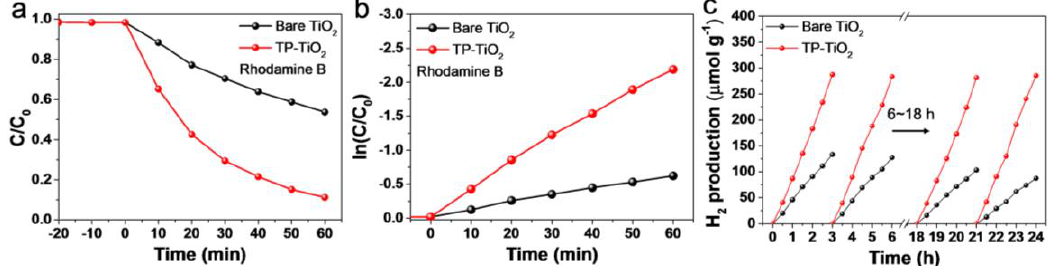
Figure 3. ( a ) Concentration changes in rhodamine B aqueous solution by photodegradation; ( b ) Natural logarithmic plots for the study of the kinetics of rhodamine B photodegradation profiles; ( c ) Photocatalytic hydrogen production and cycling performance during 24 h of continuous reaction in the presence of 1 M KHCO 3 .